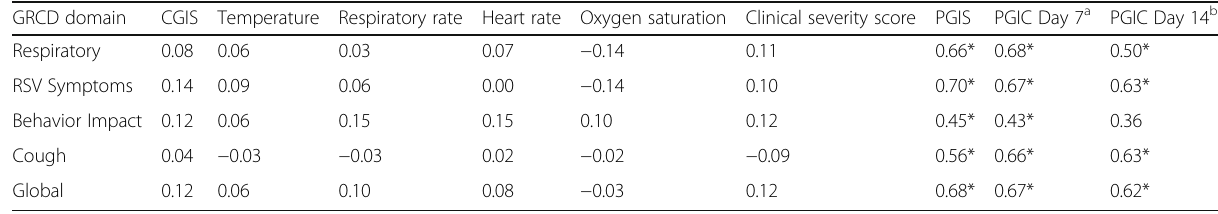
Table 3 Construct validity correlations ( n = 49 to 78) GRCD